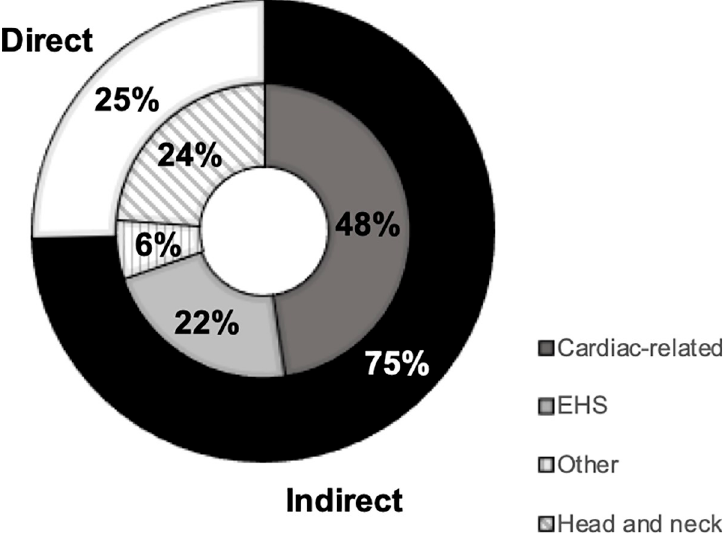
Fig 1. Type and cause of sports-related fatalities reported to Japan Sports Council that occurred during organized high school sports between 2009 and 2018 in Japan. Abbreviation: EHS, exertional heat stroke.